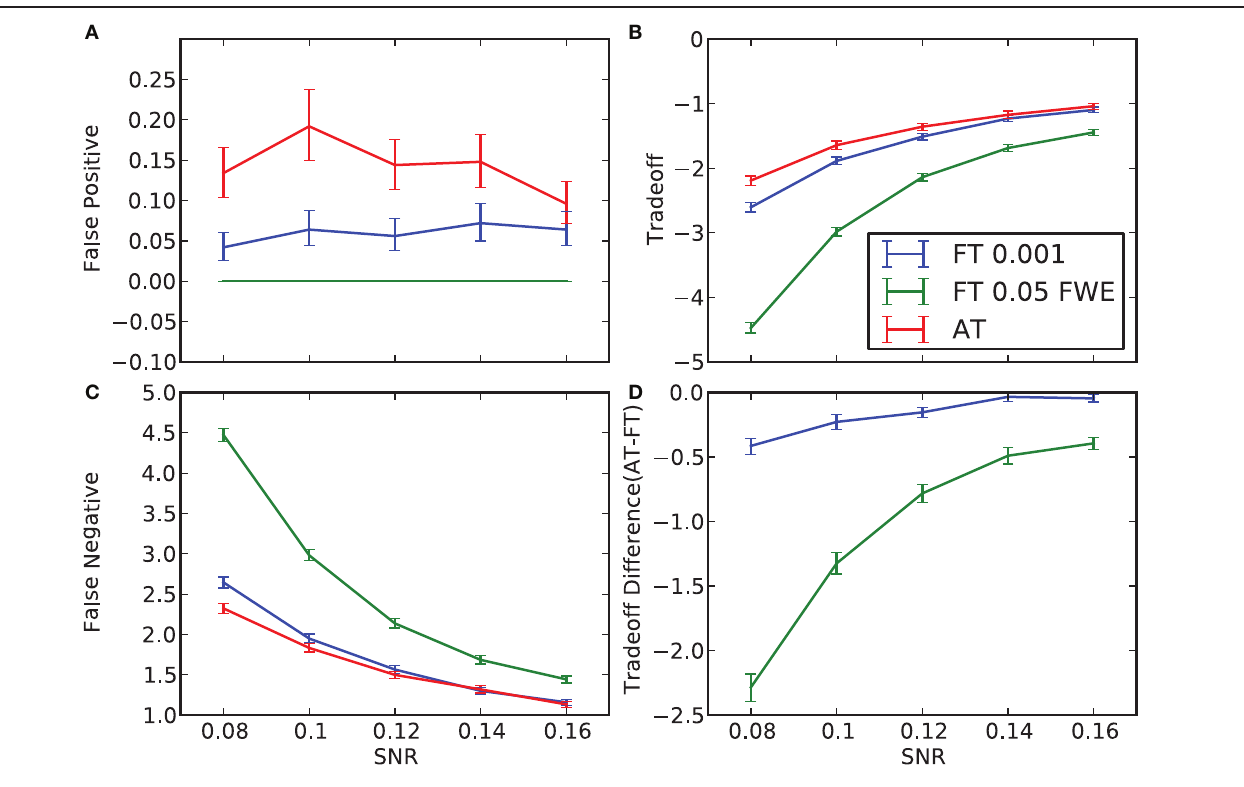
FIGURE 2 | False positive and negative cluster rates. On the left are displayed the mean false positive (A) and negative (C) cluster rates. On the right are displayed the mean clusters trade-off (B) and the difference